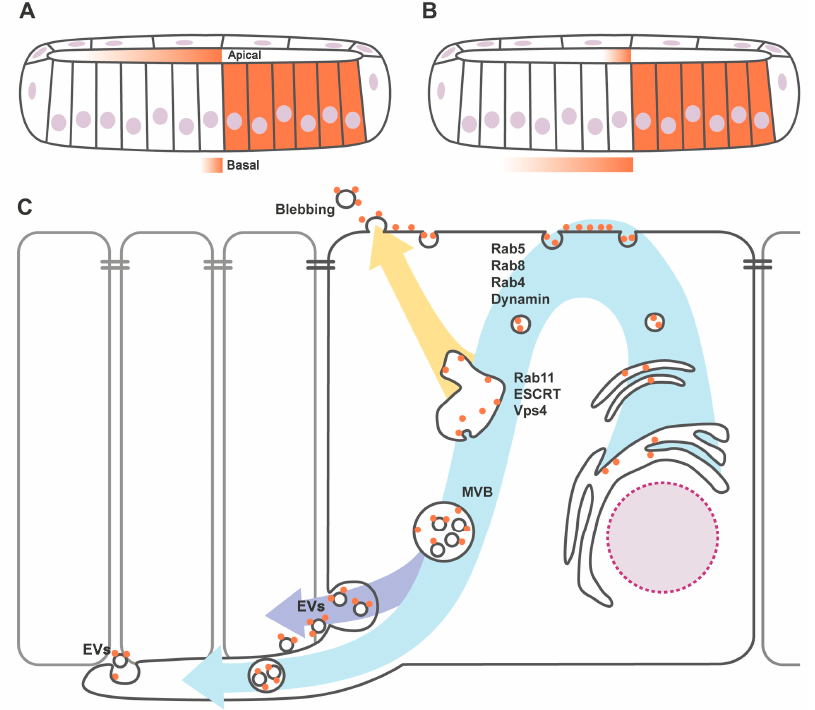
Figure 1. Schematic representation of Hedgehog (Hh) secretory trafficking and apicobasal polarity of the Hh gradient. ( A , B ) Scheme of a transversal section of a wing imaginal disc to show the two proposed models of Hh gradient formation. One model proposes that apically secreted Hh contributes to short-range signaling while basolaterally secreted Hh forms the long-range gradient formation [7,33] ( A ); alternative model suggests that apical Hh fraction activates long-range signaling while Hh basal fraction contributes to short-range signaling [50,54] ( B ); ( C ) Hh secretory trafficking. Hh is secreted after synthesis, processing and lipid modifications in endoplasmic reticulum. The Hh apical pool is then internalized in a process in which Rab5, Dynamin and Rab8 are implicated [33,54,63]. After this endocytic event, Hh follows the Multivesicular body (MVB) pathway to be secreted basolaterally ( violet arrow) and probably travels associated to cytonemes ( light blue arrow). These exovesicles (EV) most probably travel inside cytonemes [6,8]. Alternatively, other reports propose that the internalized Hh pool from the apical membrane is re-secreted apically ( yellow arrow) involving, among others, endosomal sorting complexes required for transport (ESCRT) machinery and Vacuolar protein sorting-associated protein 4 (Vps4), and that Hh EV are formed via blebbing of the apical plasma membrane without implications of cytonemes in Hh gradient formation